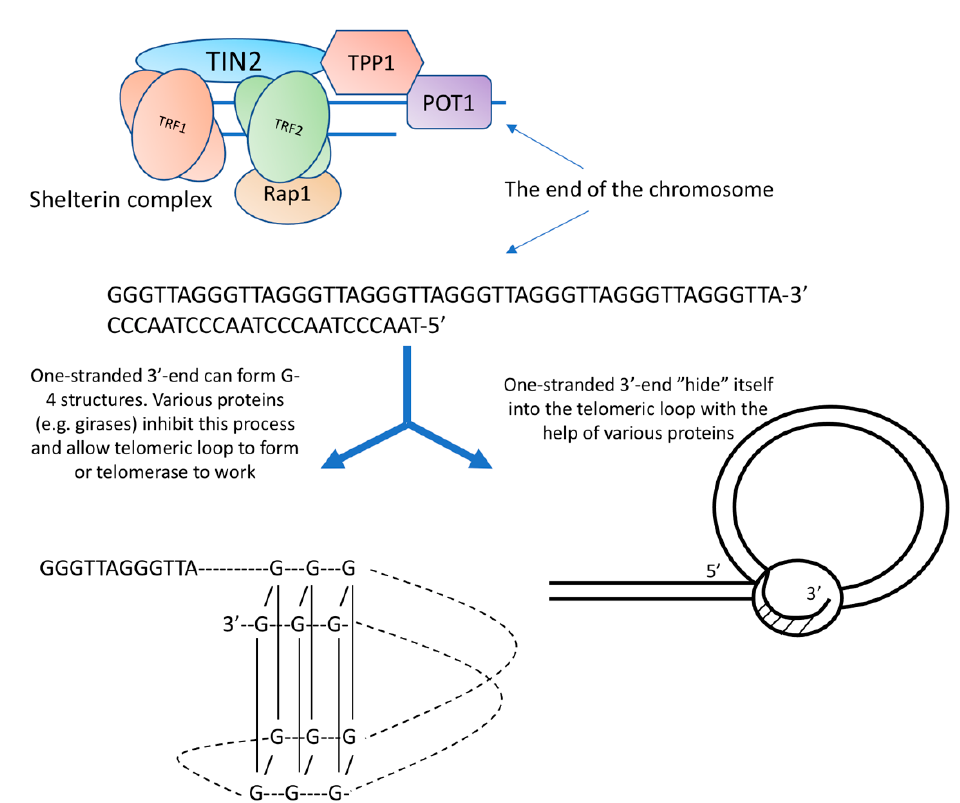
Figure 1. A highly simplified diagram of the molecular organization of telomeres.